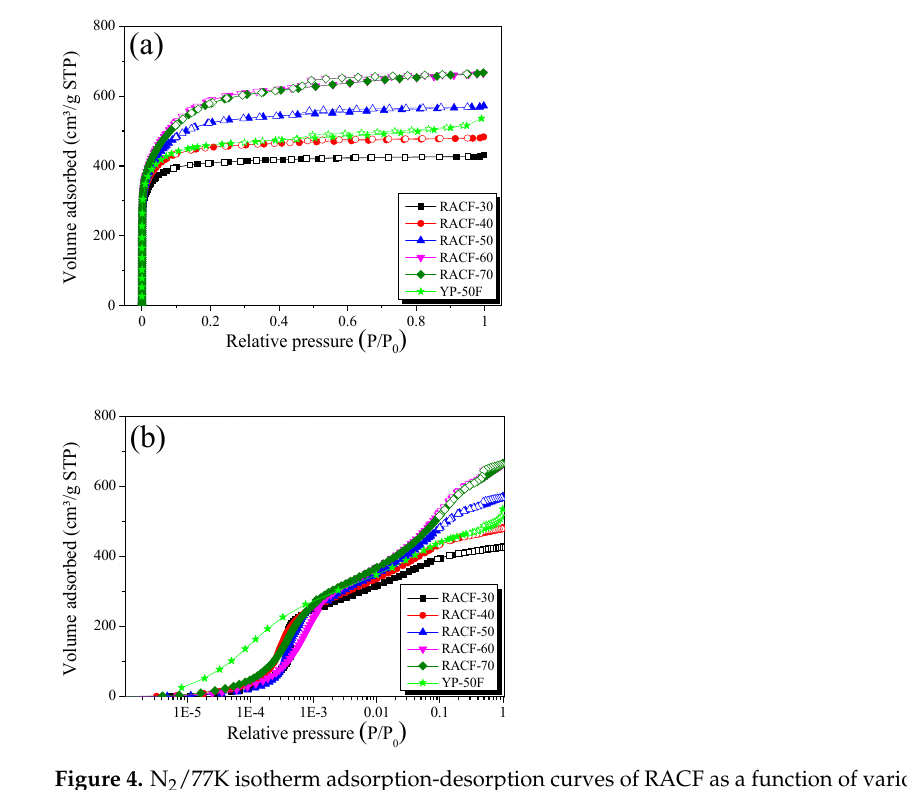
Figure 4. N 2 /77K isotherm adsorption-desorption curves of RACF as a function of various activation conditions; ( a ) normal and ( b ) logarithmic. conditions; ( a ) normal and ( b )